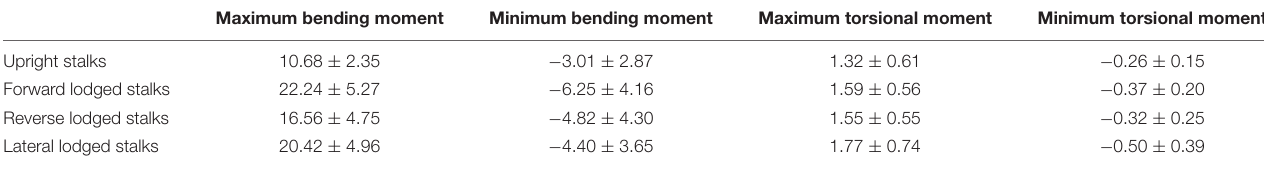
TABLE 1 | Bending moments and torsional moments on stalks in corn harvesting